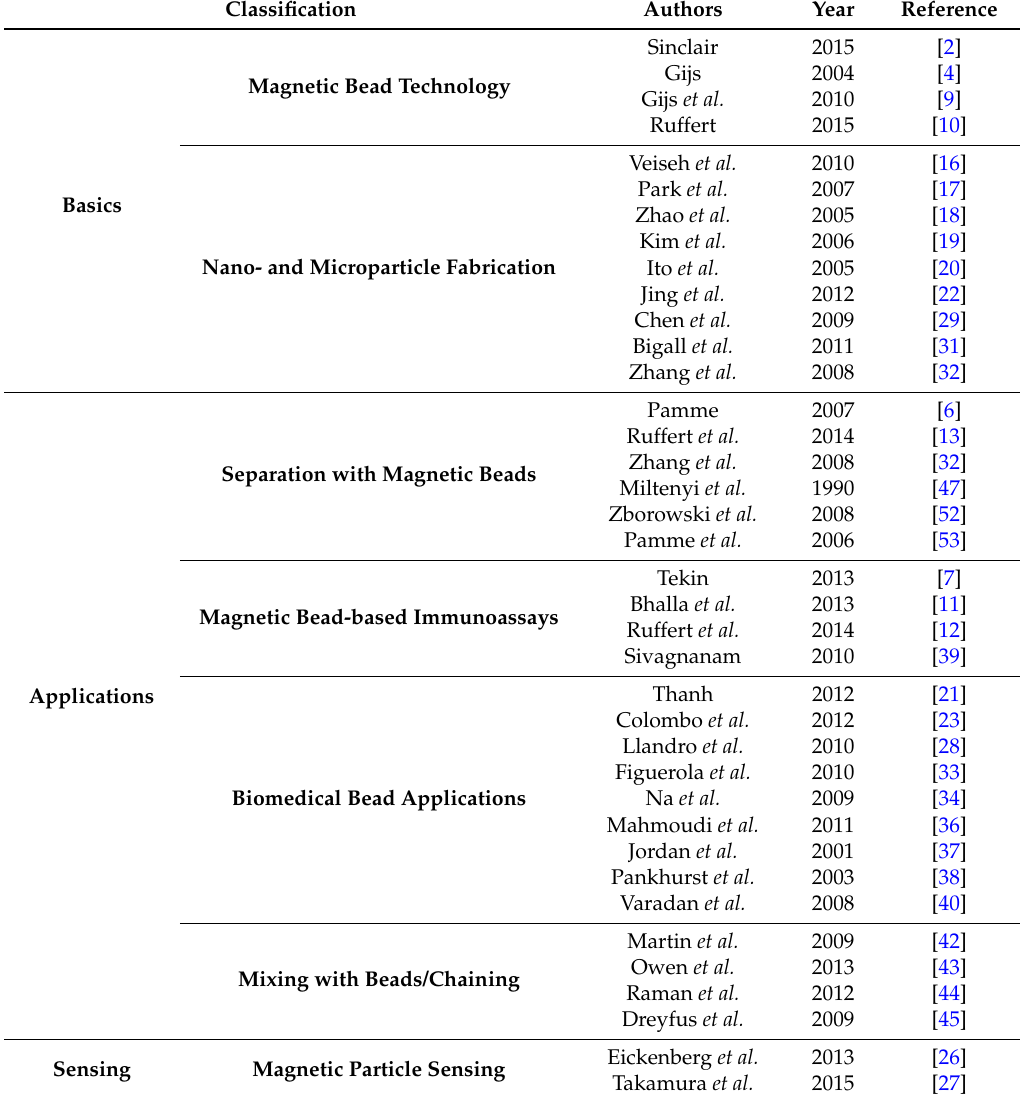
Table 1. Overview of the scope of this paper and related